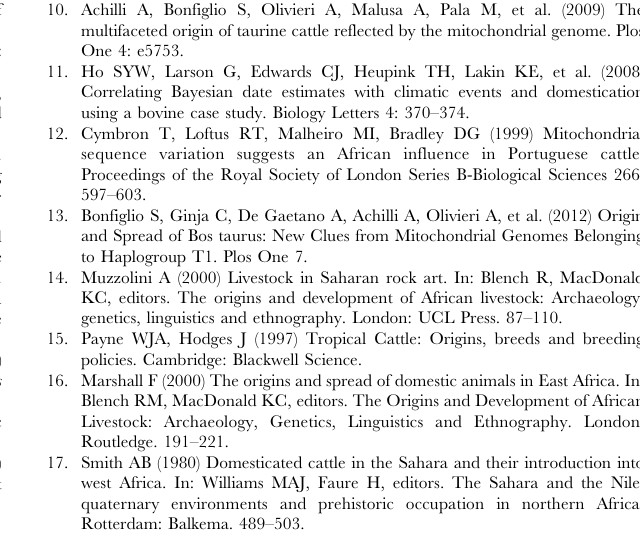
Table S2 PCR primer sequences. Table S3 PCR fragment